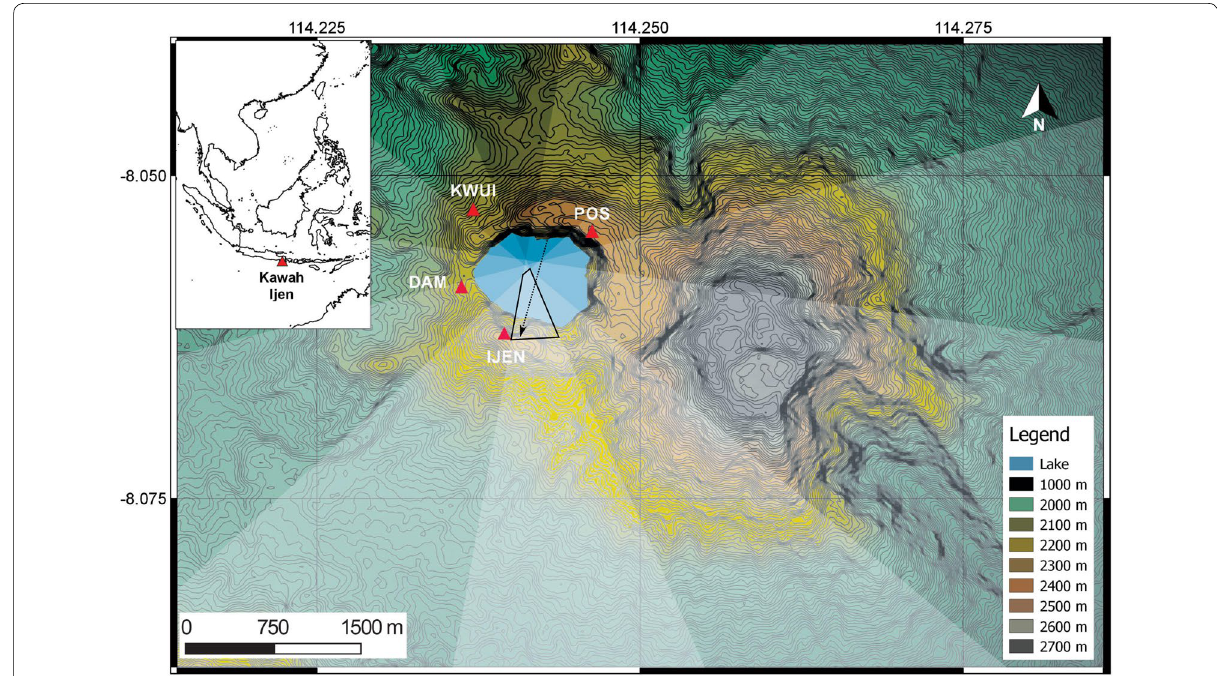
Fig. 9 Source location of HF bursts (the transparent triangles relate to a level of confidence in amplitude ratio locations, whiter shades corresponding to more probable locations whereas darker to less probable). The amplitude ratios between 5 and 15 Hz were used to estimate the most likely source locations [between 16:00 and 17:00 UTC (Fig. 8b)]. The polygon shows the most probable source location for a vertical migration whereas the arrow highlights the possible trajectory of the lateral